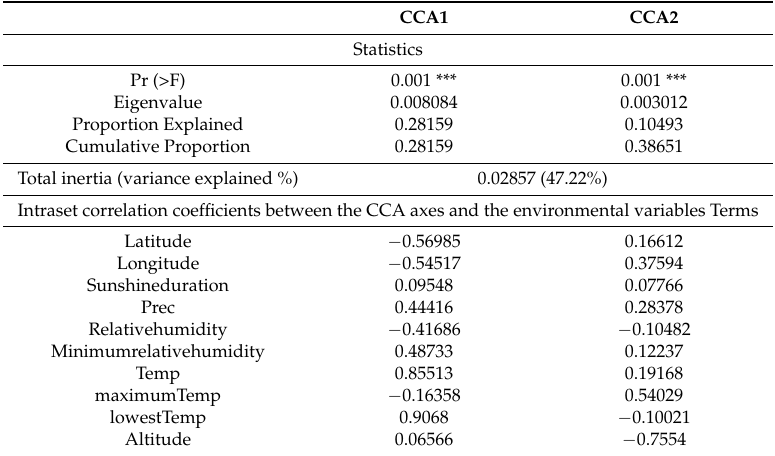
Table 4. CCA results for seed and fruit traits of Sapindus mukorossi with environmental